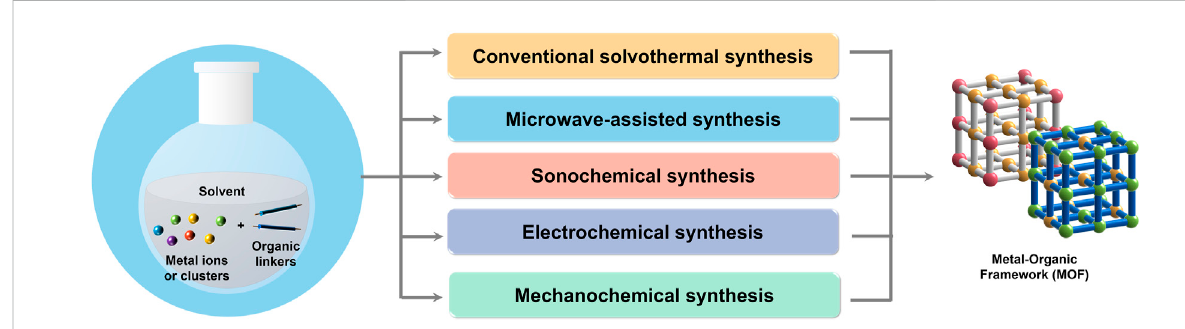
FIGURE 1 Illustration of MOF synthesis. Different methods synthesize MOF from metal ions/clusters and organic ligands, self-assembling them to form porous crystalline materials with repeating structural units.